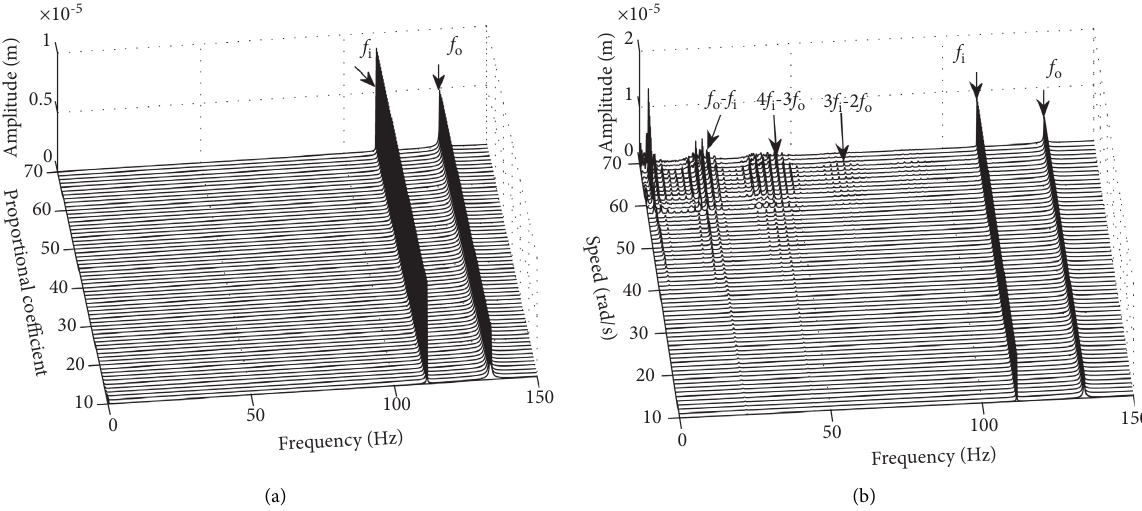
Figure 20: Waterfall plots of the MSDS with K